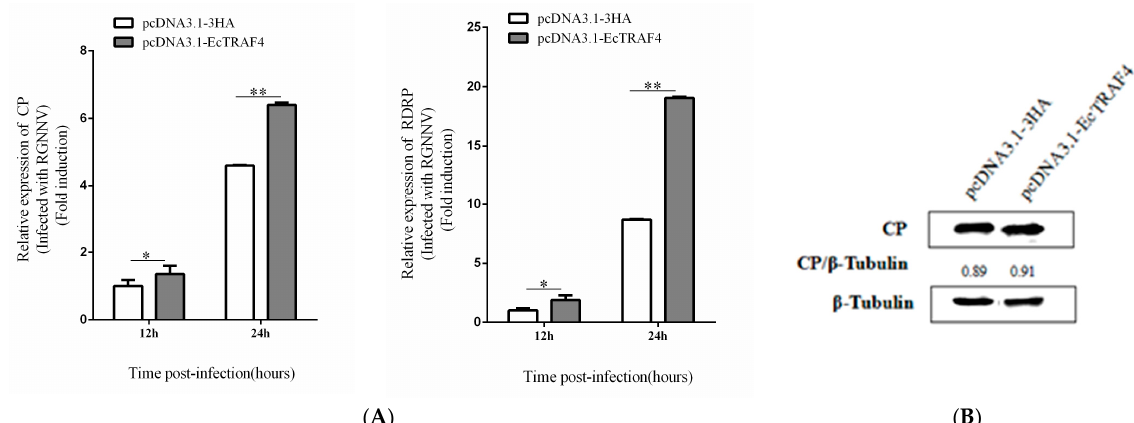
Figure 5. Effect of EcTRAF4 overexpression on RGNNV replication. ( A ) EcTRAF4 overexpression increased RGNNV gene transcription. Expression levels of CP and RdRp were measured using qRT-PCR (means ± S.E., n = 3). Statistical difference is with each pcDNA3.1-3HA-transfected cell. Asterisk denotes a significant difference (* p < 0.05 and ** p < 0.01). ( B ) Virus protein level after transfection with EcTRAF4. The level of RGNNV-CP was detected by western blot, and β -Tubulin was used as the internal control.